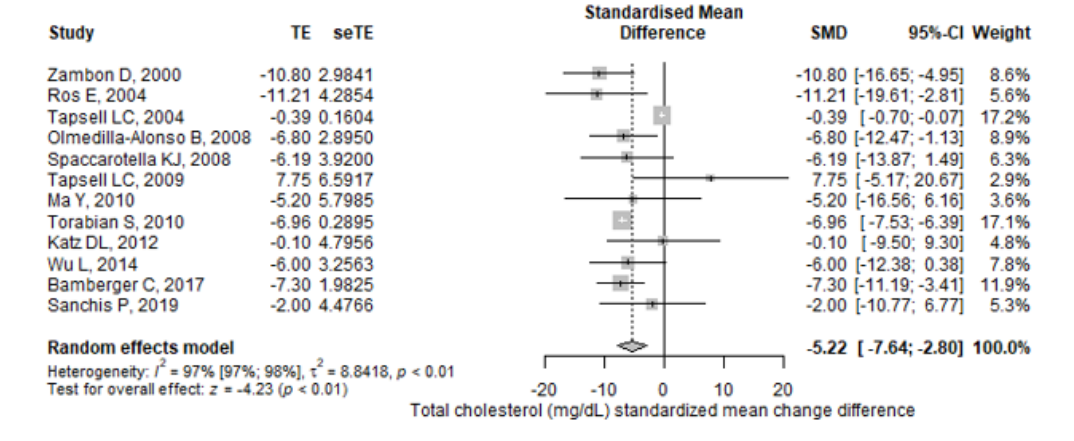
Figure 4. Forest plot for total cholesterol (mg/dL) standardized mean change difference. TE — treatment effect; seTE — the standard error of the treatment effect; SMD — standardized mean difference; CI — confidence interval.